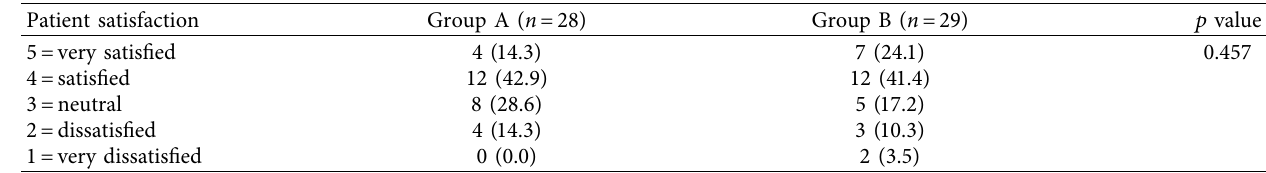
Table 5: Patient satisfaction with postoperative pain management.